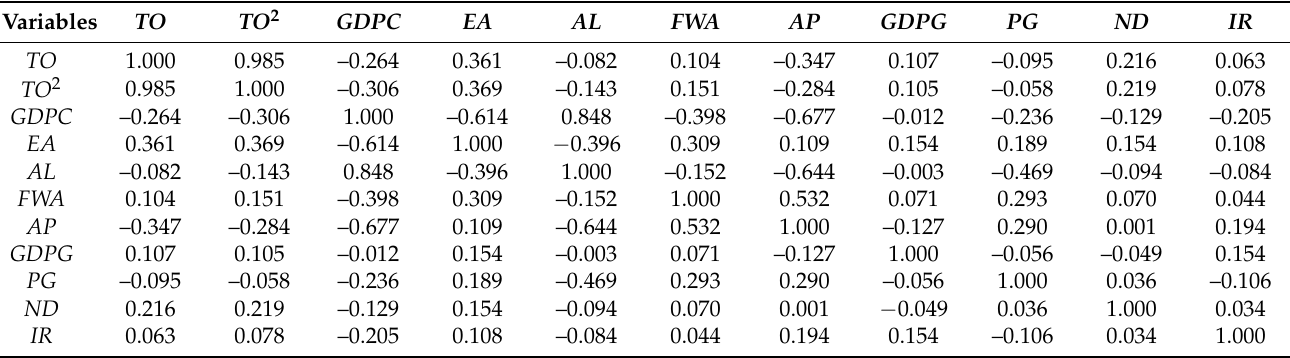
Table 3. Correlation analysis results between independent